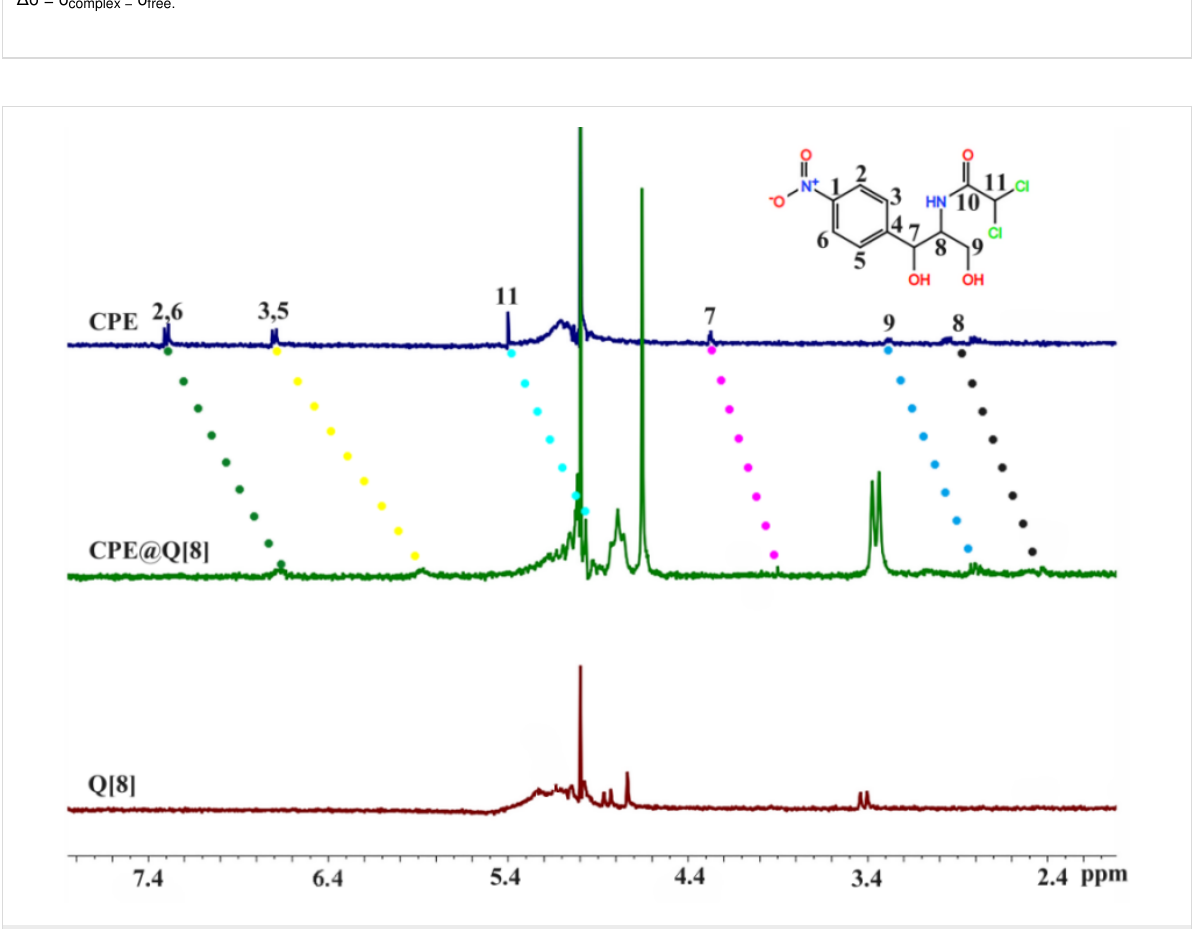
Figure 5: 1 H NMR spectra of CPE, CPE@Q[8] and Q[8] (V D2O /V DCl =